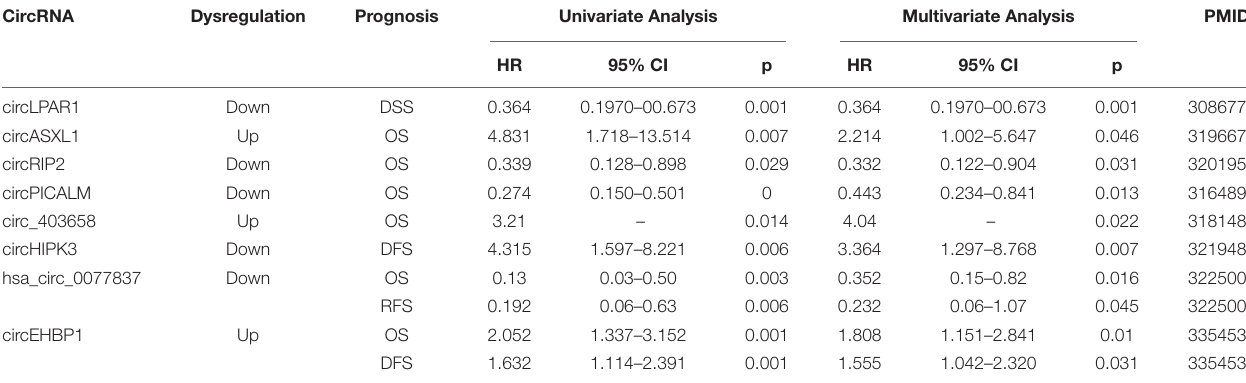
TABLE 3 | The potential circRNAs as prognostic biomarkers in bladder